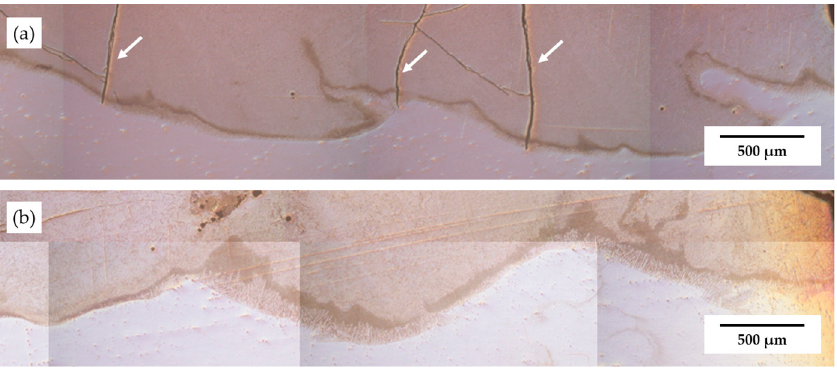
Figure 5. Cross-sectional morphologies of the coatings: ( a ) 55NiTi coating; ( b ) 55NiTi + 5Ni coat- ing.